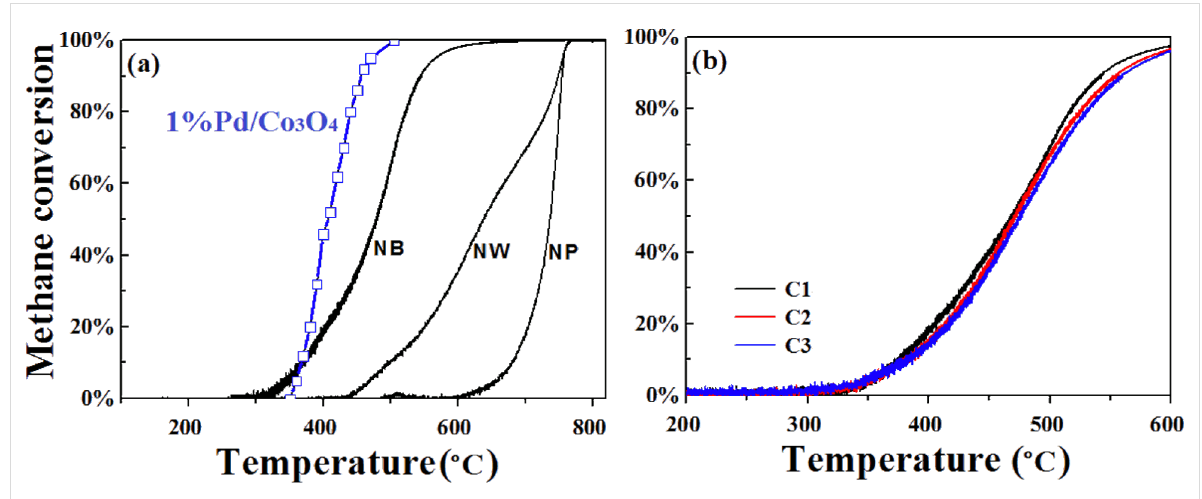
Figure 3: CH 4 conversion against the temperature. (a) Heating profile ( T max = 850 °C) for NBs, NWs and NPs, with 1% Pd/Co 3 O 4 as a reference. (b) Heating profile ( T max = 600 °C) for NBs tested for three cycles, labelled as C1, C2 and C3.